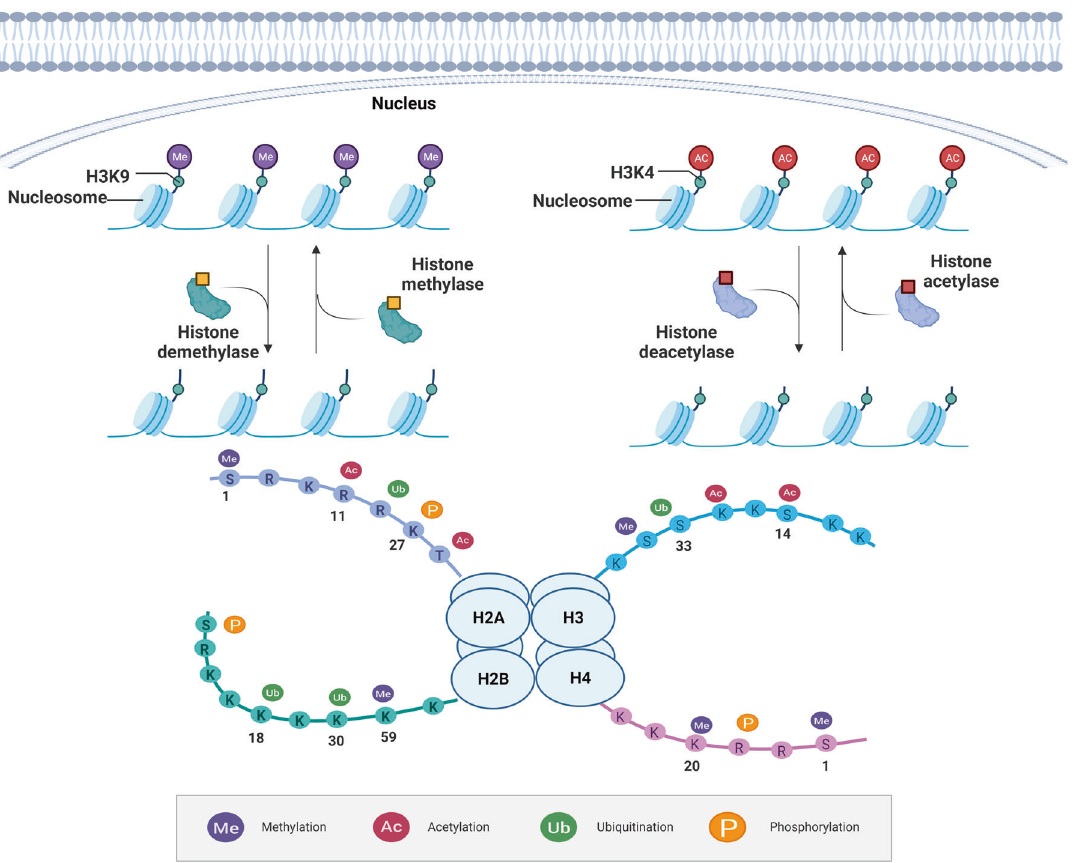
Fig. 2 Histone-modi fi cation regulation. Histone modi fi cation refers to the process of histone modi fi cation such as methylation, acetylation, phosphorylation, adenylation, ubiquitination, and adenosine diphosphate ribosylation under the action of related enzymes. Among them, histone methylation and acetylation are well studied. Histone methyltransferases are mainly involved in the regulation of histone methylation, which transfers methyl groups to histones lysine residues, whereas, histone demethylases have the opposite effect. The methylation action site is on the N atom of the lysine side chain. Histone acetyltransferases are mainly involved in the regulation of histone acetylation, which transfers acetyl groups to histones lysine residues. However, histone deacetylases have the opposite effect. This fi gure was created with the aid of Biorender (https://biorender.com/). H3K9 histone H3 lysine 9, H3K4 histone H3 lysine